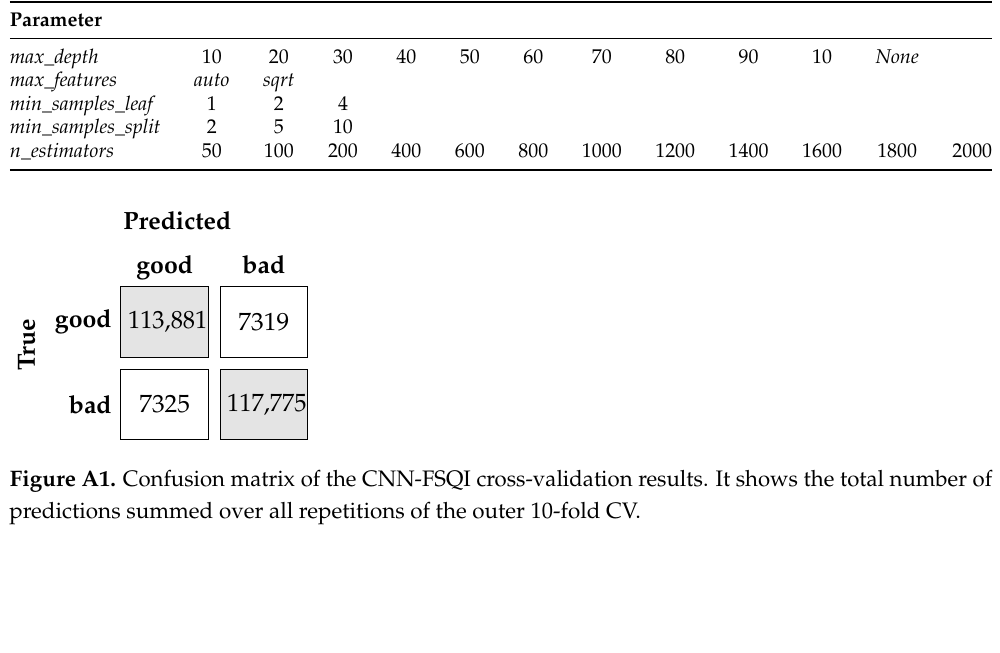
Table A3. Grid search parameters for the RF.